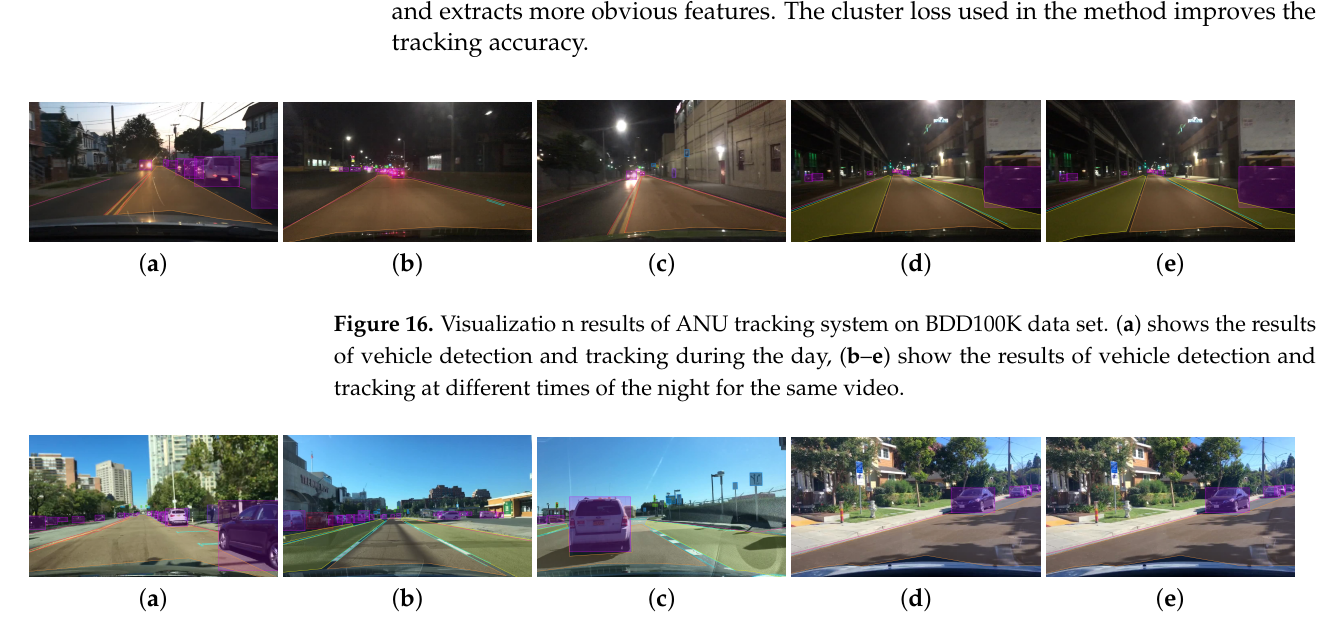
Figure 17. Visualization results of UWIPT tracking network on BDD100K data set, where ( a – e ) show the results of detecting and tracking vehicles in different scenes of the same video.